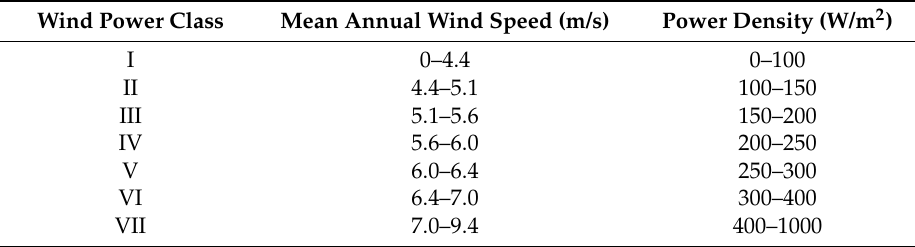
Table 4. Wind classification defined in USA [43].